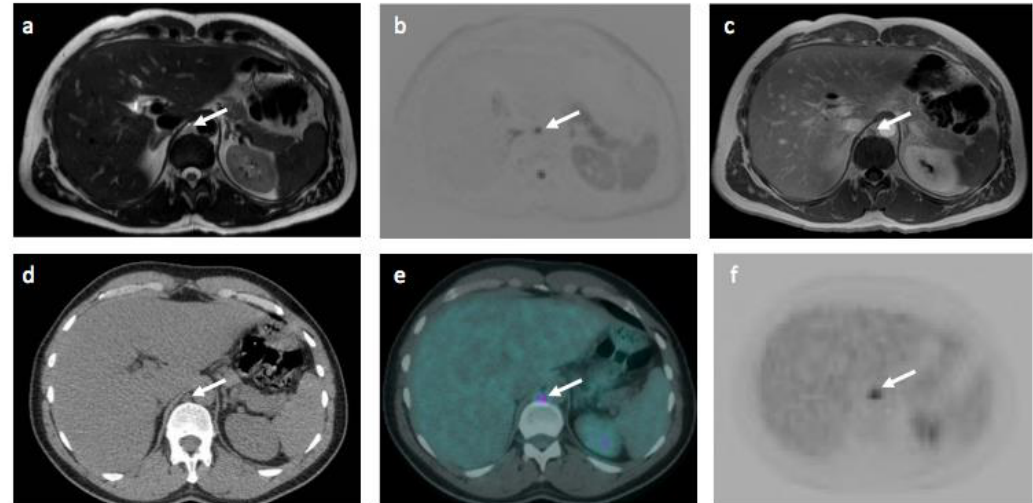
Figure 4. Images of 46-year-old male patient with Hodgkin’s lymphoma highlighting a false negative technical error on WB-MRI. A sub-centimeter FDG avid (SUV max 5.1) retrocrural lymph node that was considered negative nodal site on WB-MRI. The positive nodal station is shown (arrows) on ( a ) T2-TSE, ( b ) DWI b1000 and ( c ) Contrast-enhanced in-phase mDixon WB-MRI images and ( d ) CT scan, ( e ) fused 18 F-FDG PET-CT and ( f ) 18 F-FDG PET images.